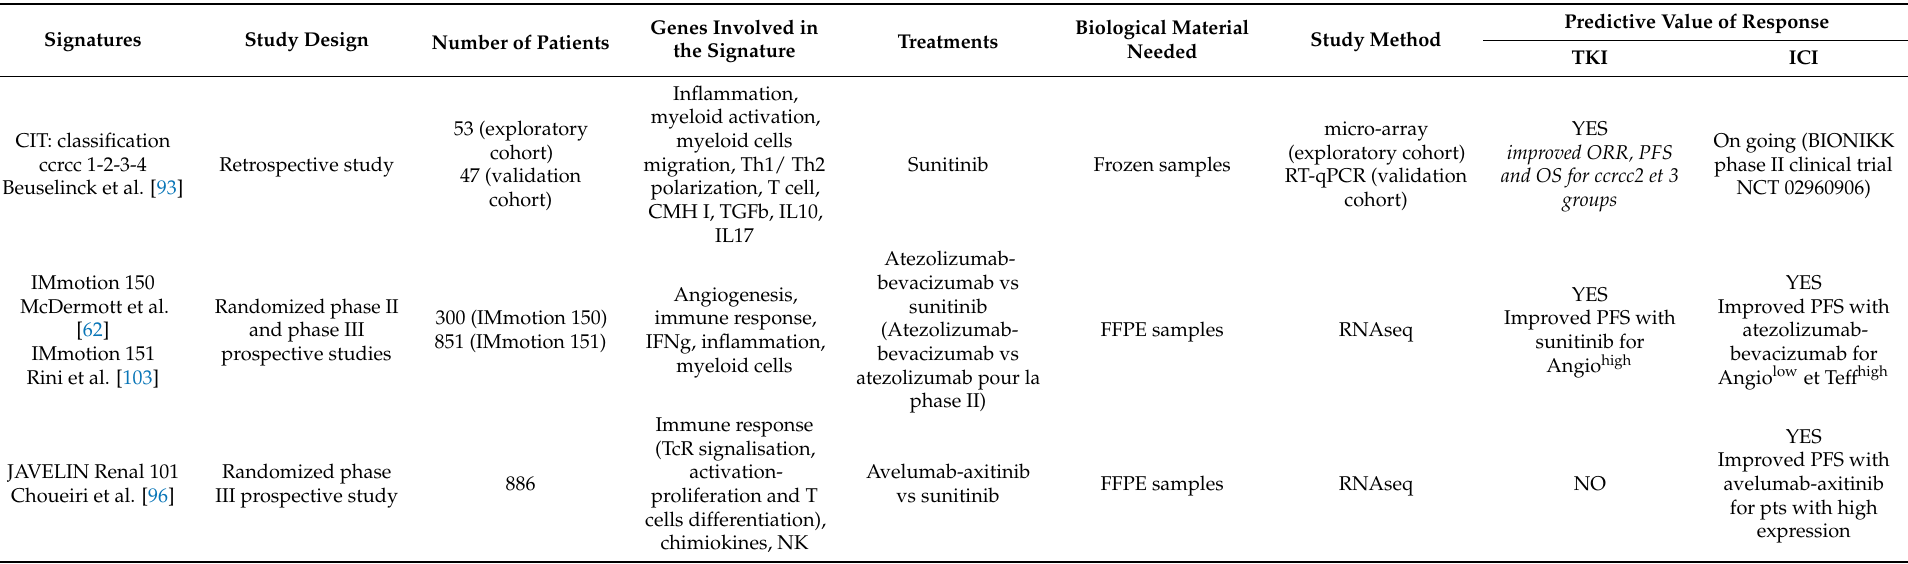
Table 2. Main technical characteristics and predictive values of the responses of the three major signatures evaluated in metastatic renal cell carcinoma. RT-qPCR: reverse-transcriptase quantitative PCR, IL: interleukin, TGF- β : transforming growth factor β , PFS: progression-free survival and FFPE: Formalin-Fixed